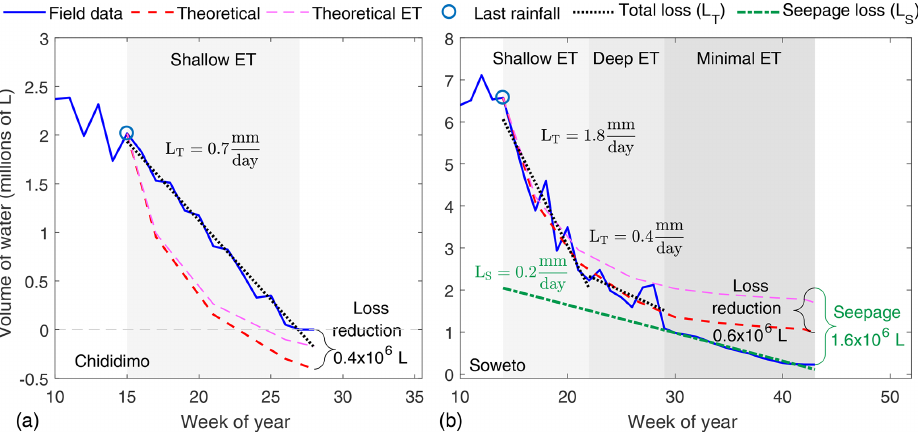
Figure 9. Volume of water in the area enclosed by the WTMWs of the (a) Chididimo and (b) Soweto sand dams. The field data line shows the volume of water in the study area during the specified week. The theoretical line, initiated at the end of the rainy season, shows the theoretical volume of water in the study area, calculated by integrating Eq. (1) and subtracting from the field-determined volume of water at the end of the rainy season. The theoretical line accounts for losses due to evapotranspiration, baseflow–groundwater runoff, and community use. The theoretical ET line shows the portion of total theoretical loss attributed to ET in the FLDAS